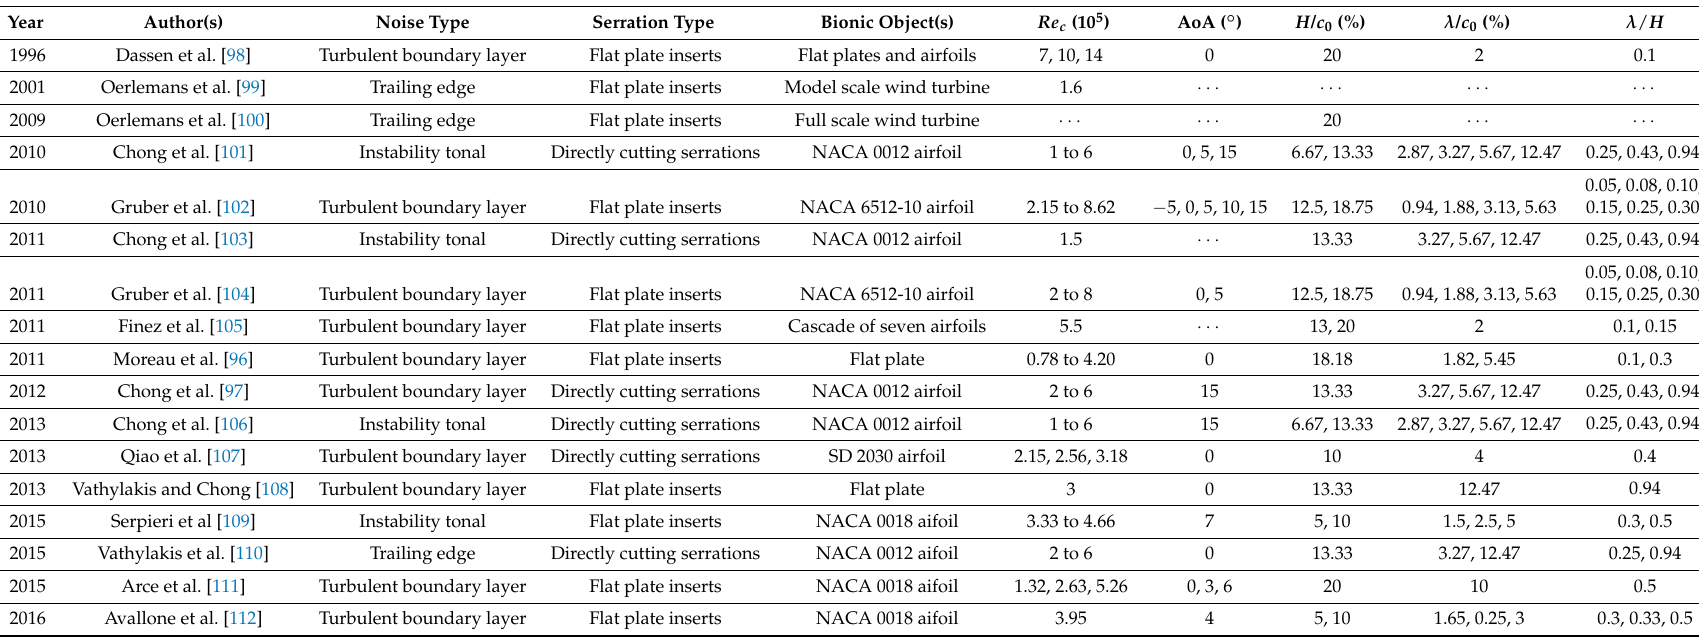
Table 5. Selected investigations of acoustic effect of trailing edge serrations (“ · · · ” denotes “not